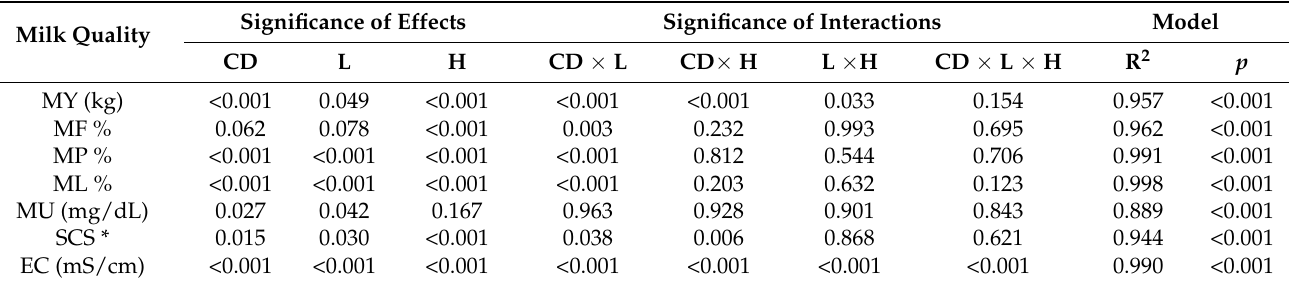
Table 5. Assessment of the statistical significance ( p ) of the effects of calving ease, lameness-related health status, herd and interactions on milk yield and quality traits in